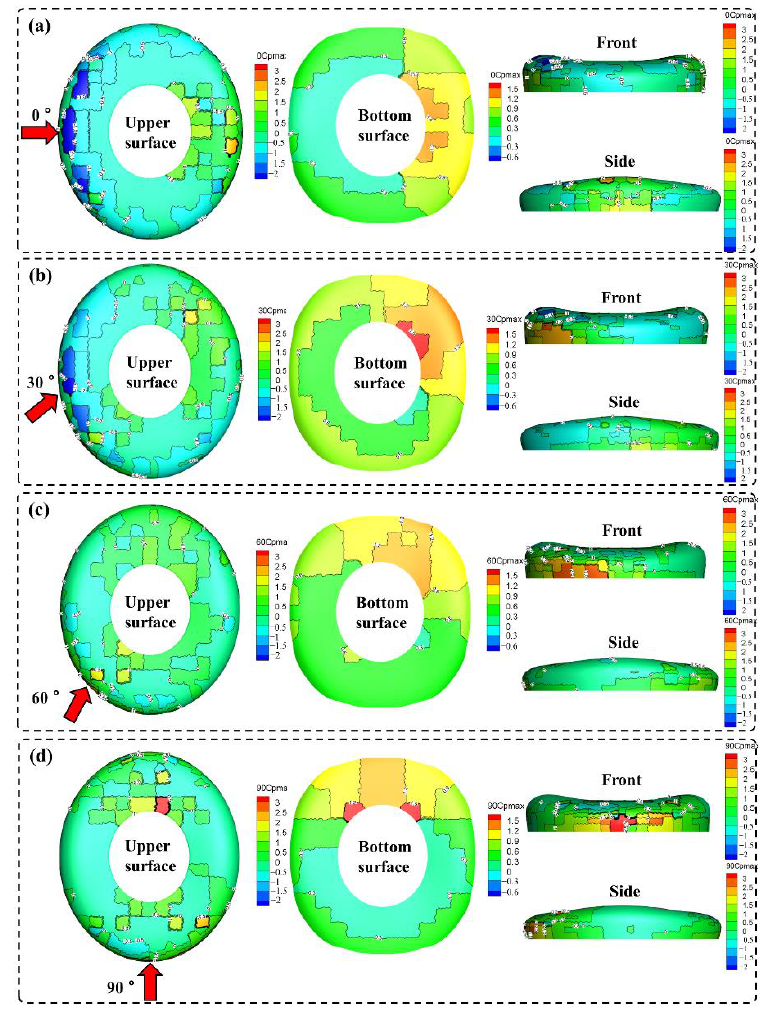
Figure 17. Maximum value of wind pressure coefficient at each wind direction angle for working case 2: ( a ) 0°; ( b ) 30°; ( c ) 60°; ( d ) 90°.